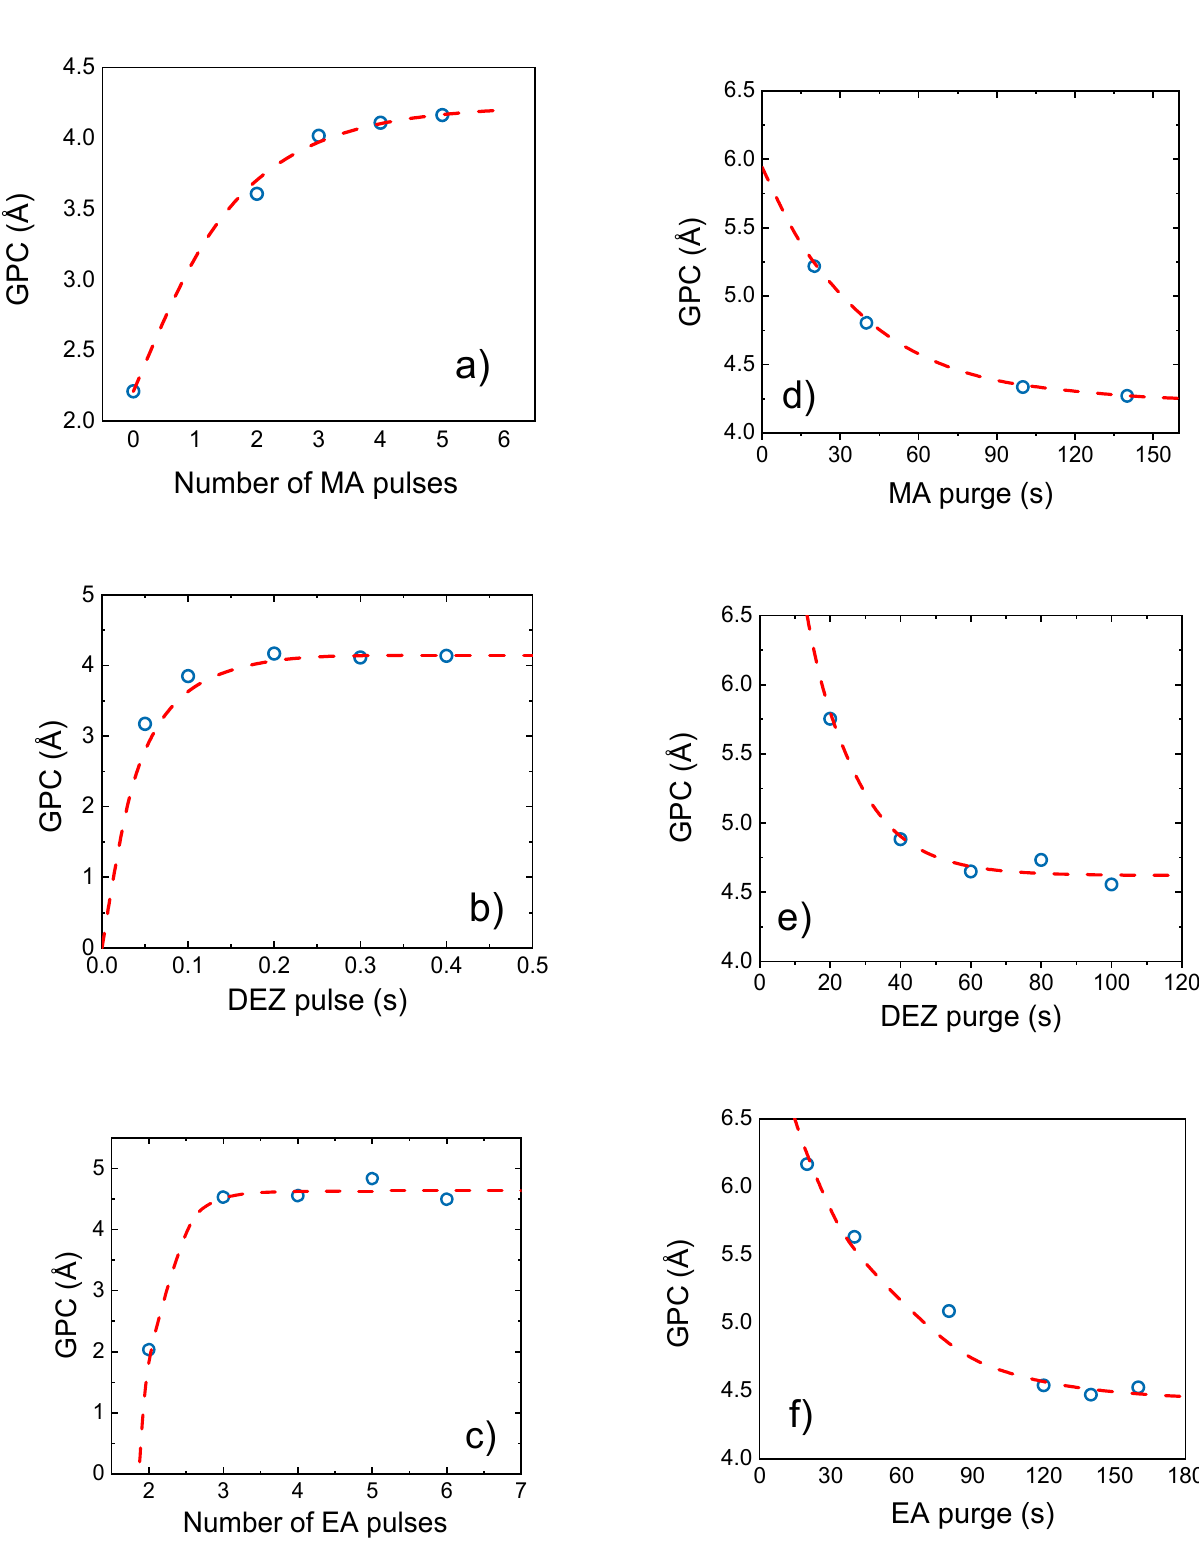
Figure 6. Saturation curves for the 3-step ABC cycle using the precursors DEZ, EA, and MA and a stage temperature of 60 °C. The growth per cycle (GPC) is reported as a function of ( a ) variable number of MA pulses (0.1 s pulse time) during one MA exposure step. ( b ) Single DEZ pulses of variable pulse time. ( c ) Variable number of EA pulses (1.5 s pulse time) during one EA exposure step. ( d – f ) MA, DEZ, and EA purging using an Ar flow rate of 16